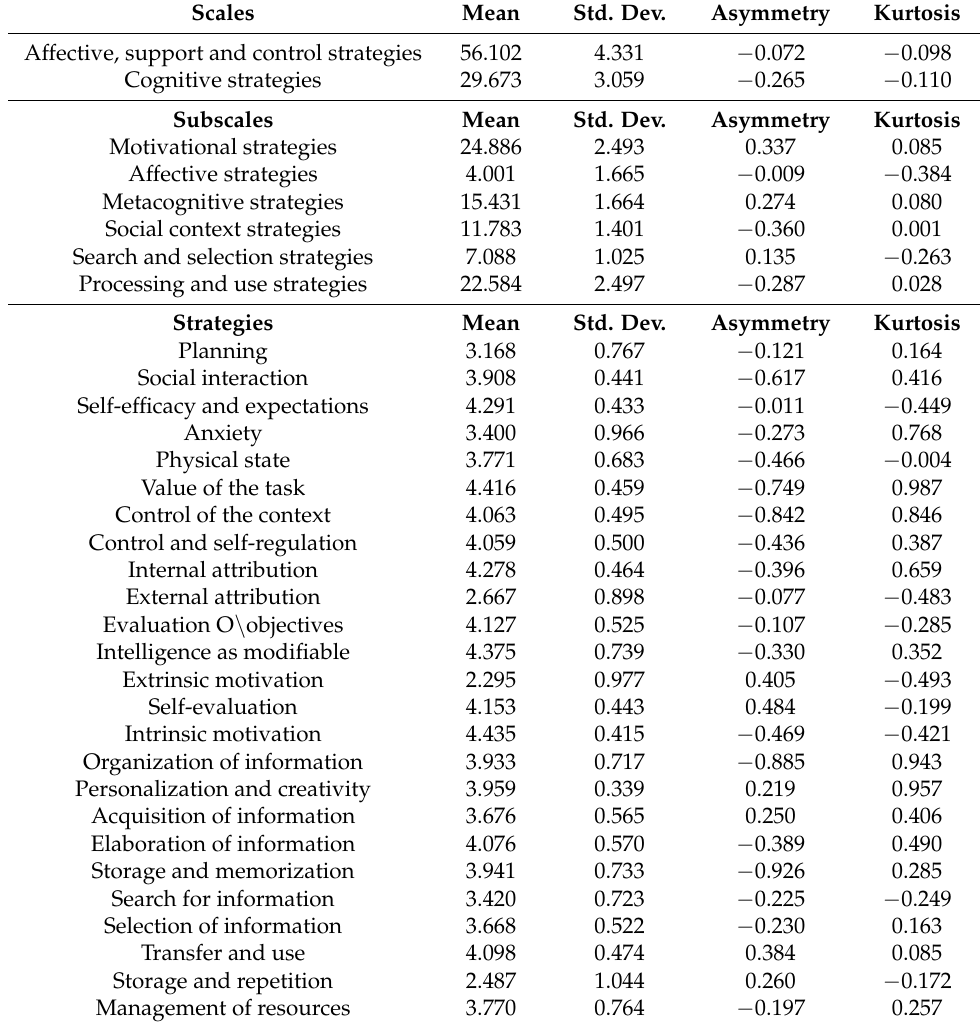
Table 2. Descriptive statistics of the Scales, Subscales, and Strategies of the CEVEAPEU. Scales Mean Std. Dev. Affective, support and control